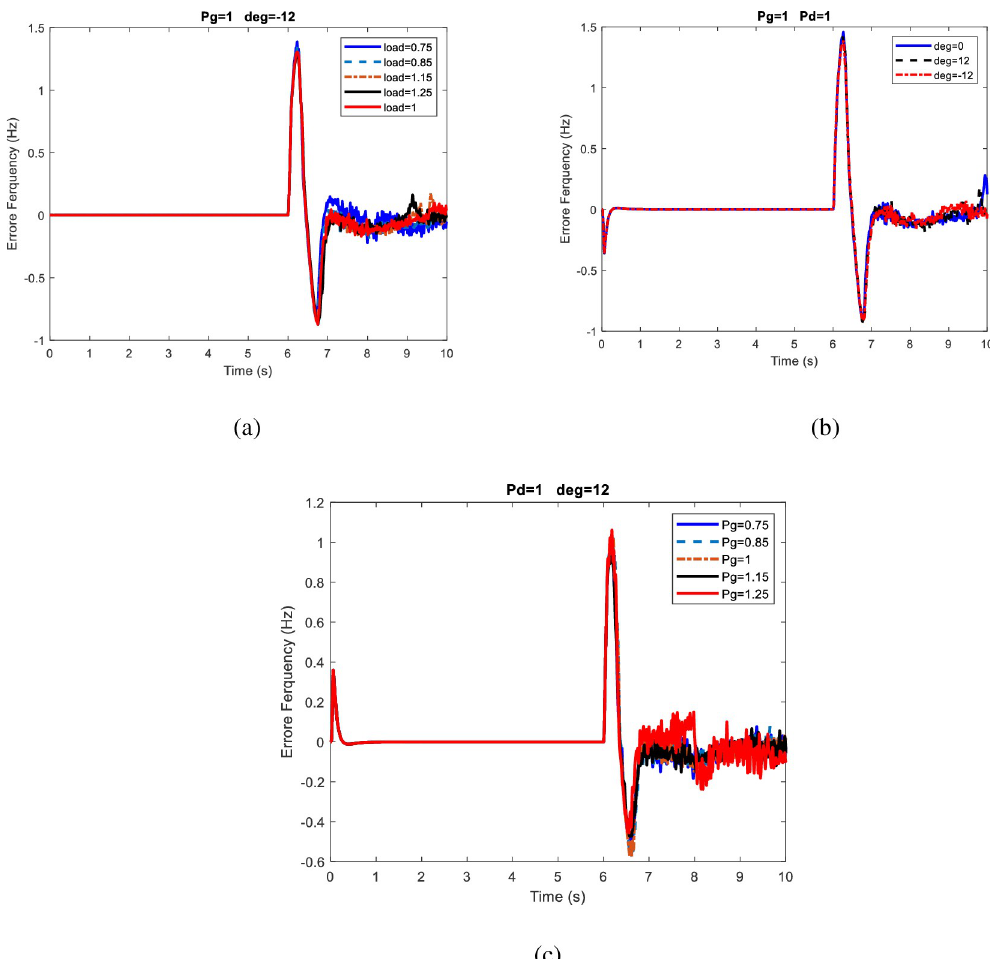
Fig 8. Comparison of frequency deviation in different modes for the third scenario.